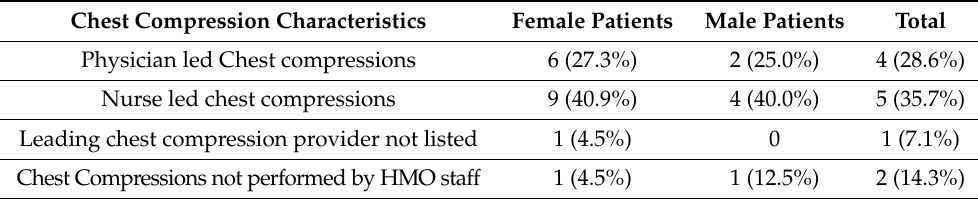
Table 1. Characteristics of Cardiopulmonary resuscitation in adults.